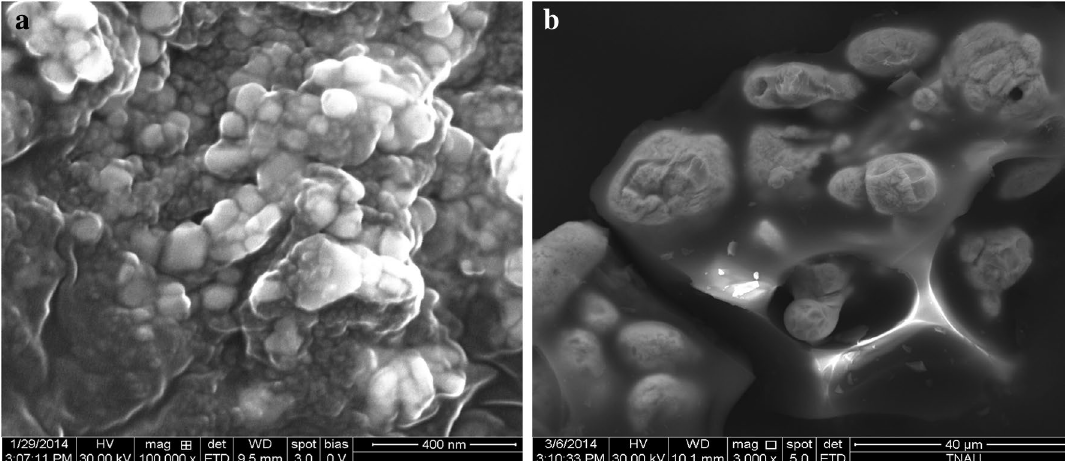
Figure 4. ( a ) SEM image of carbon sphere before loading. ( b) SEM image of carbon sphere after loading.